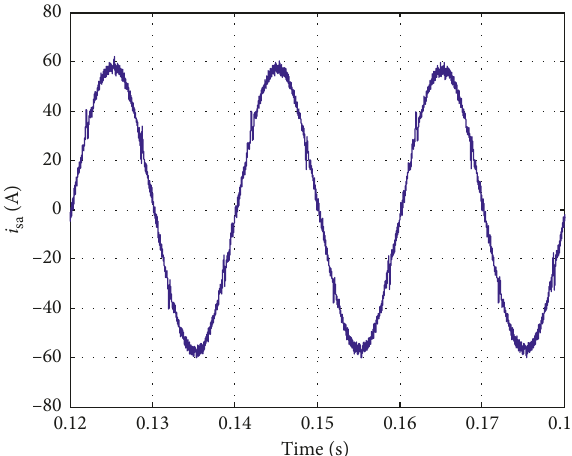
Figure 15: Waveform of source current using PI controller and 6th VR